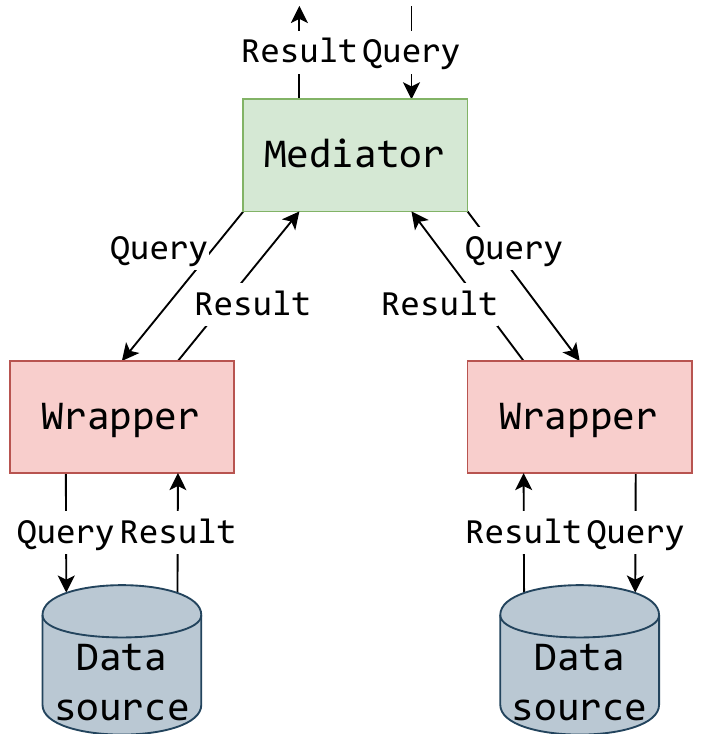
Figure 1. Relationship of mediator and wrapper components